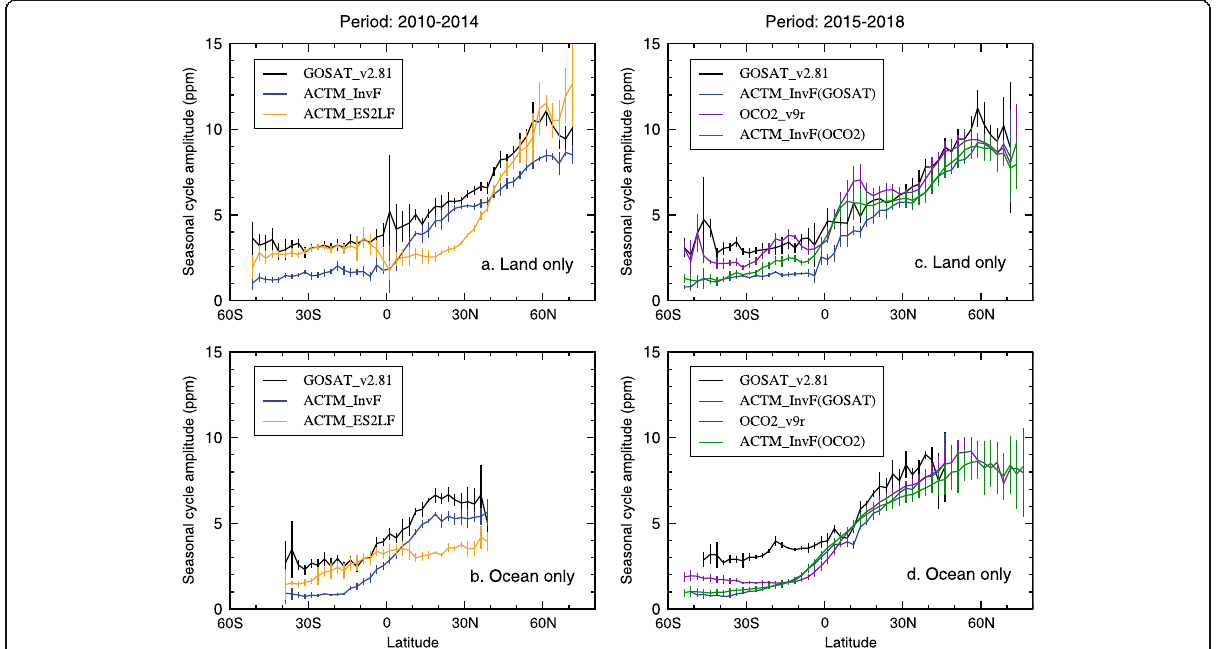
Fig. 7 Seasonal cycle amplitude of zonal mean XCO 2 , shown for land (top row) and ocean (bottom row) surfaces separately. The comparisons of XCO 2 SCAs for both the ACTM_InvF and ACTM_ES2LF simulations are compared with GOSAT observations for the 2010 – 2014 period (left column), while the ACTM_InvF simulation only is compared with GOSAT and OCO-2 observations for the 2015 – 2018 period (right column). The error bars represent 1- σ standard deviations over 5 years in the left column and over 4 years in the right column. The ACTM_invF(GOSAT) and ACTM_invF(OCO-2) in panels c and d show the ACTM_InvF results when sampled at the location and time of GOSAT and OCO-2 measurements,